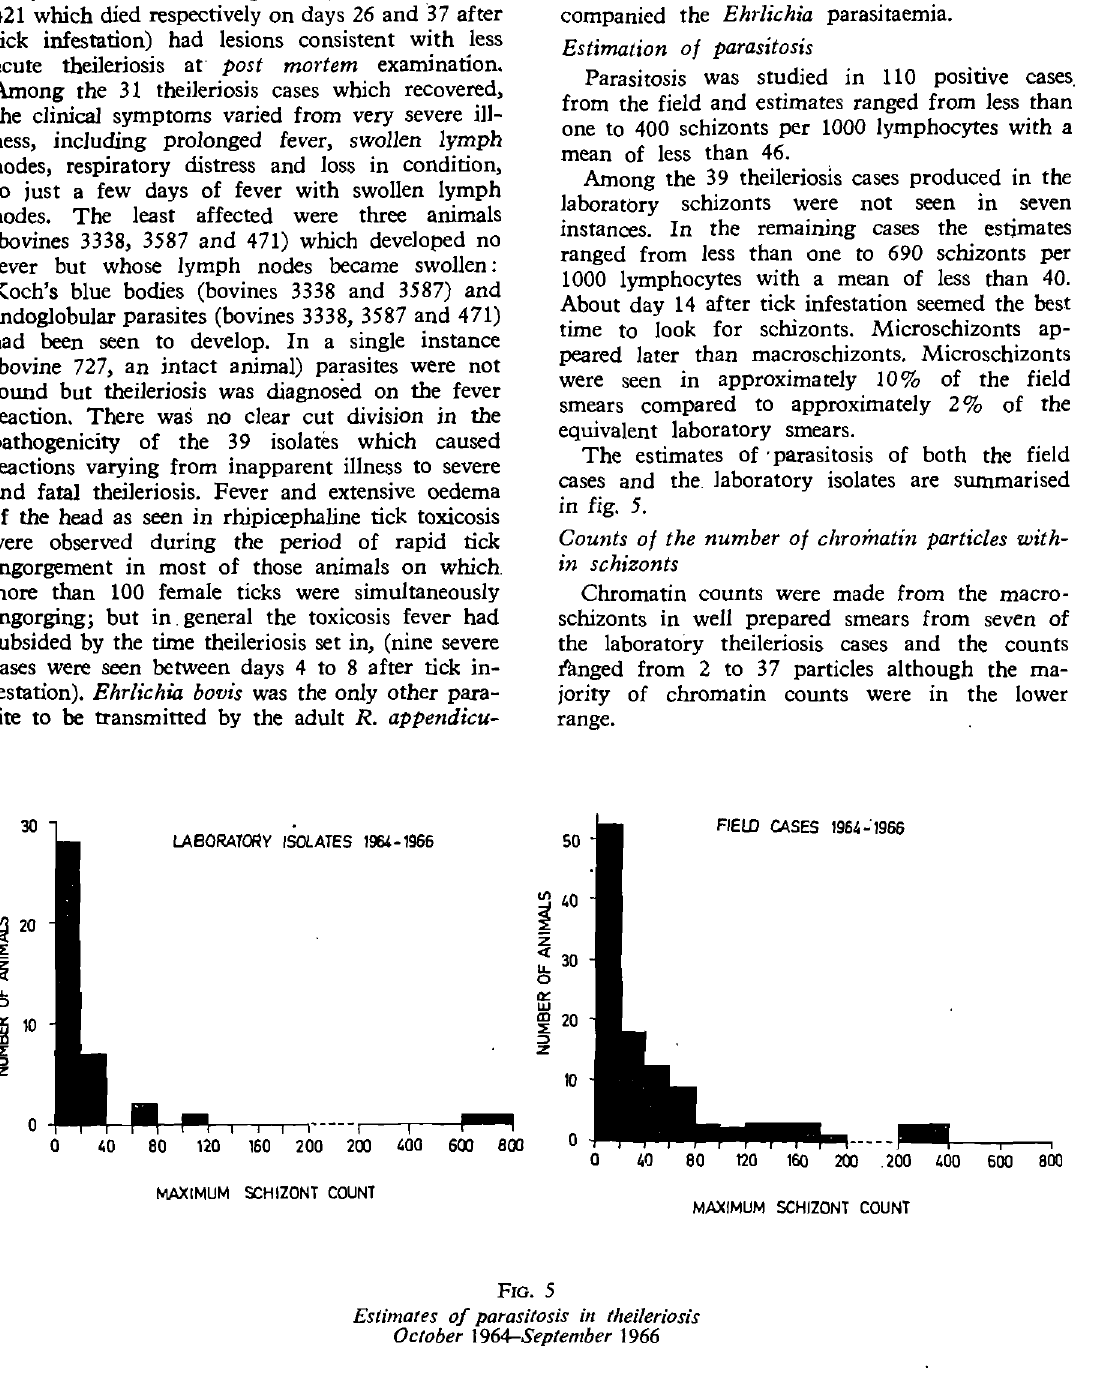
FIG. 5 Estimates 0/ parasitosis in